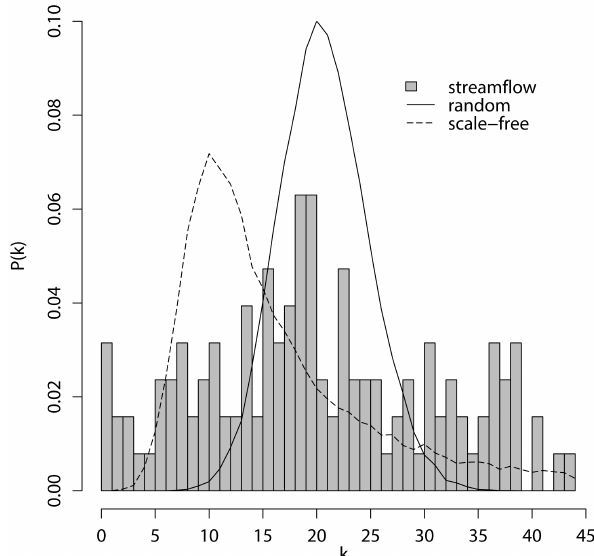
Figure 4. Discrete representation of the degree distribution for the streamflow network (grey bars). Also shown are ensemble means of the equivalent degree distributions for a random network (solid line) and for a scale-free network with P(k) ∝ k − 2 (dashed line), each having the same number of vertices and edges as the streamflow network. Not shown is the degree distribution for a regular network, which is simply a Kronecker delta function at some value of k